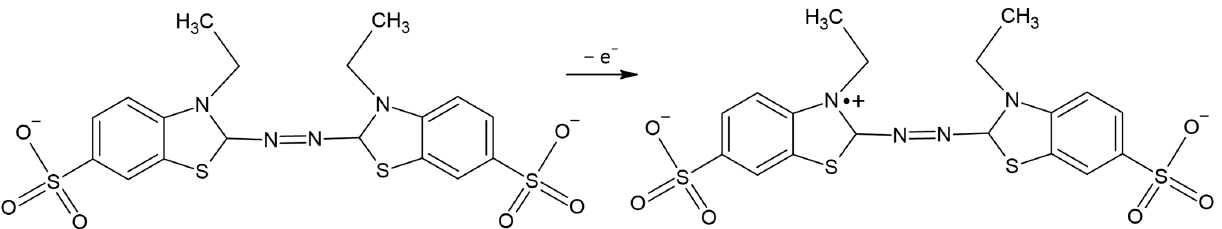
Figure 1. Formation of ABTS • by one-electron oxidation of ABTS.